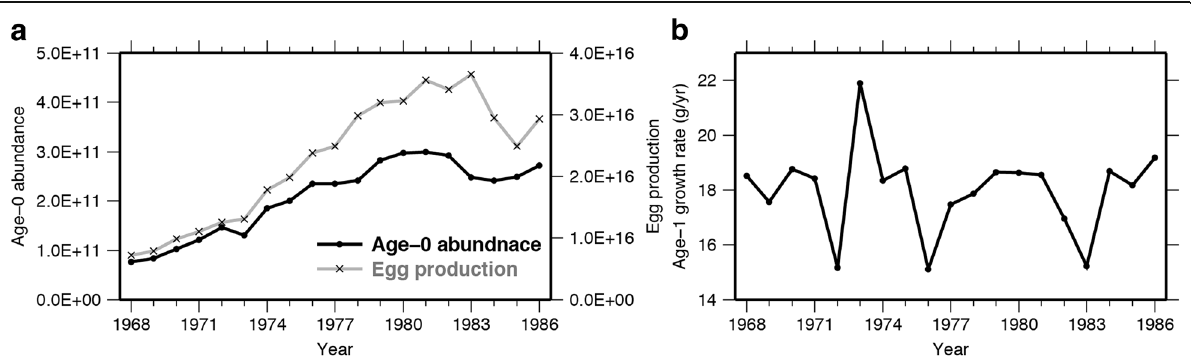
Fig. 4 Time series of simulated a anchovy age-0 abundance (black line with closed circles) and egg abundance (gray line with crosses) and b yearly growth rate of